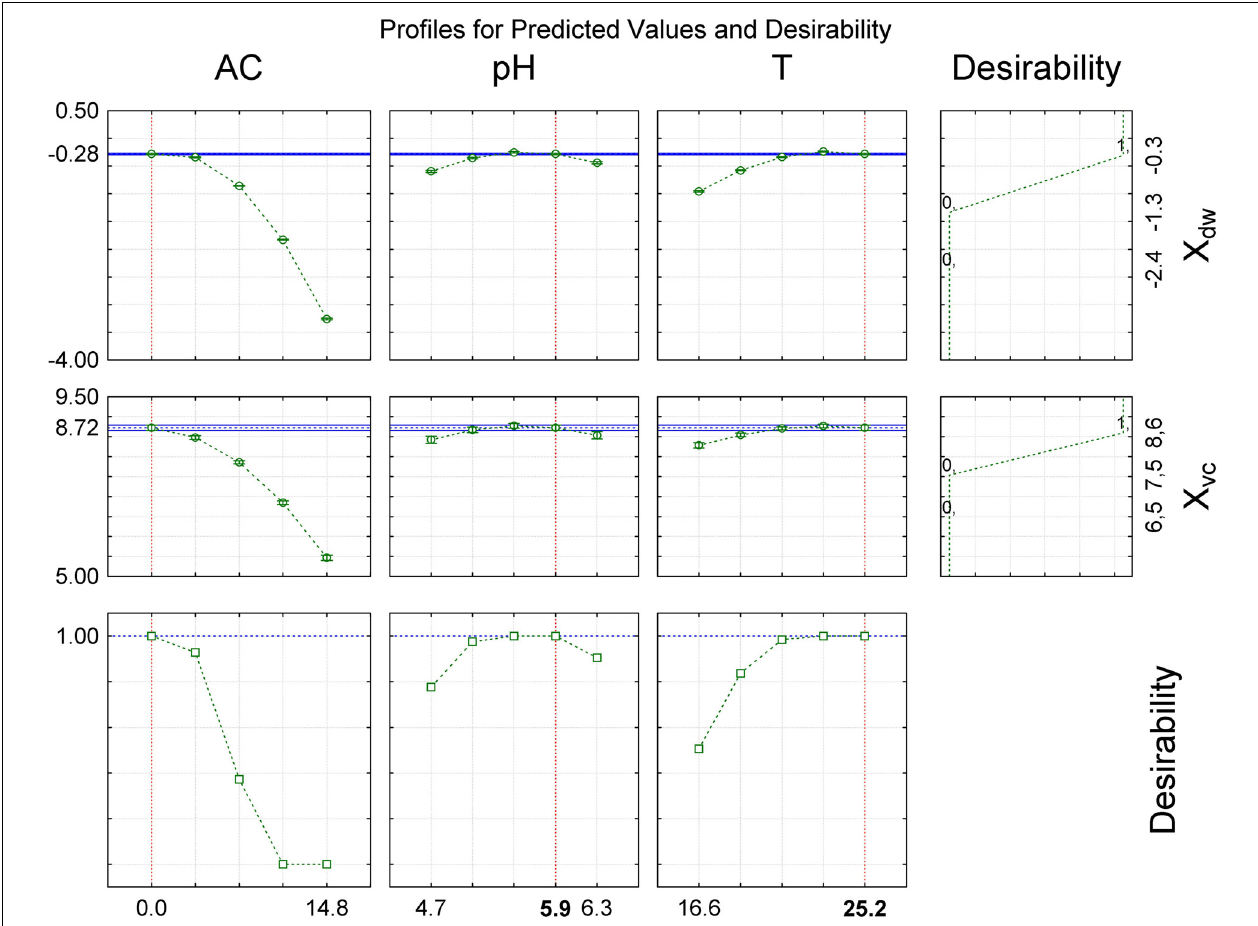
FIGURE 3 | Desirability function to evaluate the influence of independent variables to maximize the growth of S. boulardii . AC, alcohol content ( ◦ GL); pH, potential of hydrogen; T, temperature ( ◦ C); X dw , S. boulardii biomass formation (Log 10 g in dry weight L − 1 ); X vc , viable S. boulardii concentration (Log 10 viable cells mL − 1 ).